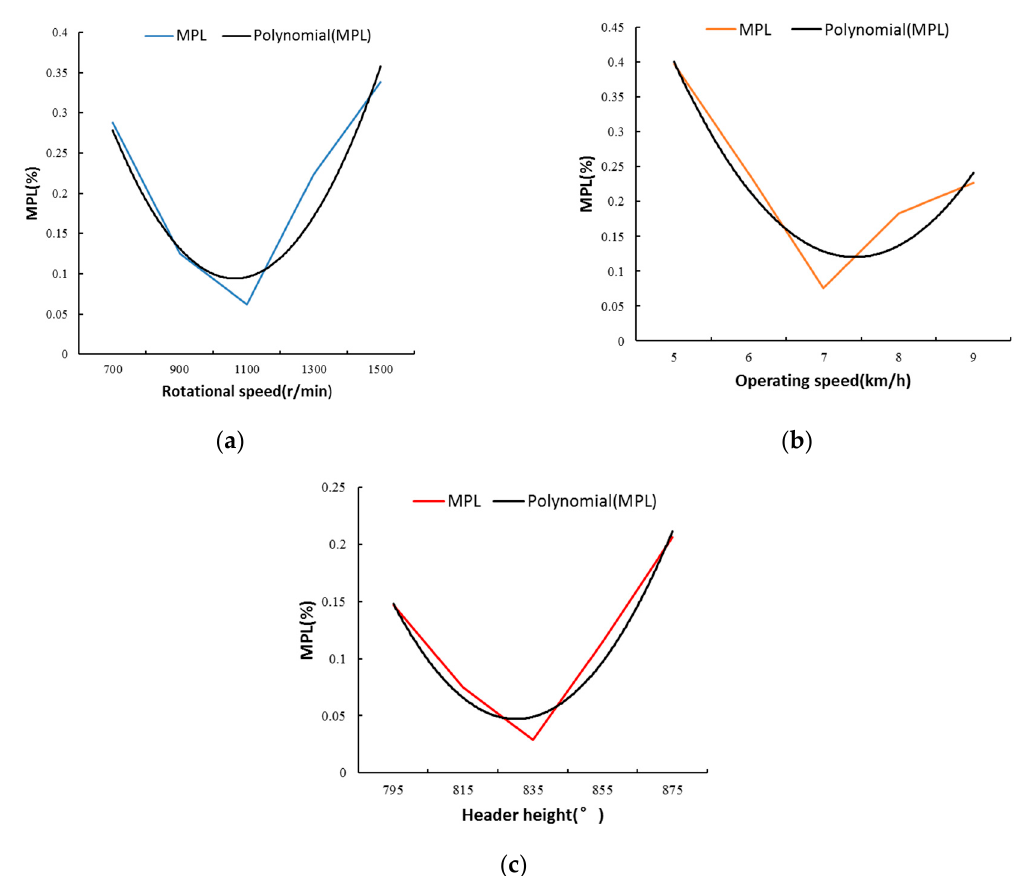
Figure 5. Relationship between the main factors and the maize picking loss rate respectively: ( a ) Relationship between the rotational speed of the pulling rollers and maize picking loss rate (MPL); ( b ) Relationship between the operating speed and MPL; ( c ) Relationship between the header height and MPL.